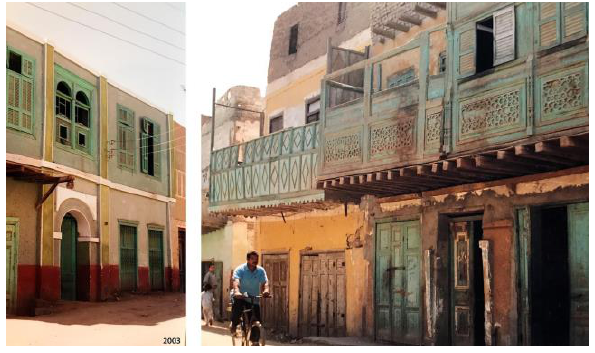
Figure 5. Two story buildings, vernacular architecture in Lahun,